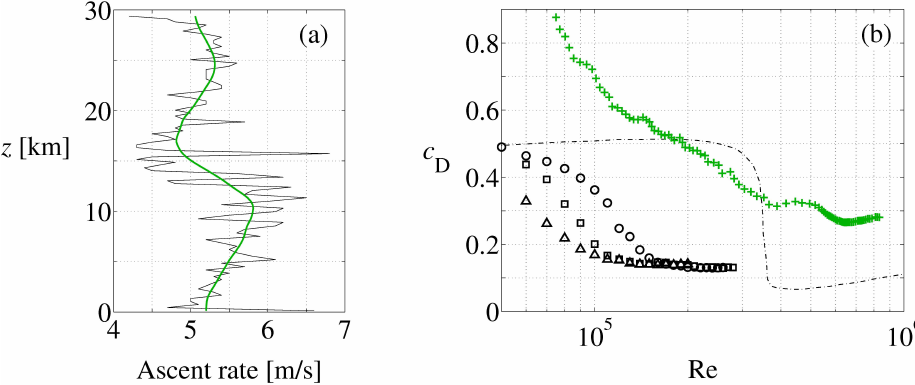
Fig. 2. Derivation of the experimental drag curve from LUAMI flight L007 launched on 7 November 2008 at 22:45UTC. (a) The 60s-low pass filtered ascent rate profile derived from the GPS data (—), and its mollified version using ε = 4km (—); (b) experimental drag curve derived using the procedure described in Sect. 2.3 ( + ). The curves of Achenbach (1972) and Son et al. (2010) for a perfect sphere are reported here for comparison (see Fig.